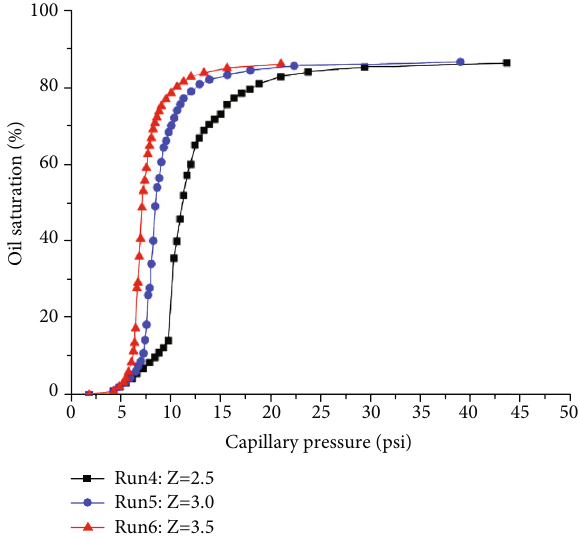
Figure 6: E ff ect of pore radius on oil charging curves.